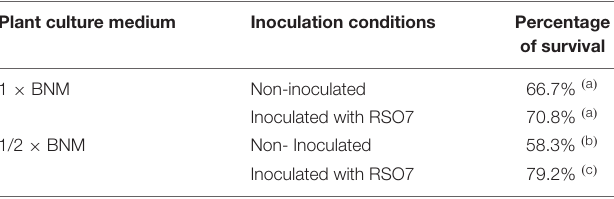
TABLE 1 | Percentage of survival of inoculated and non-inoculated plants at day 16 th in complete medium (1 × BNM) and half nutrient medium (1/2 × BNM). Plant culture